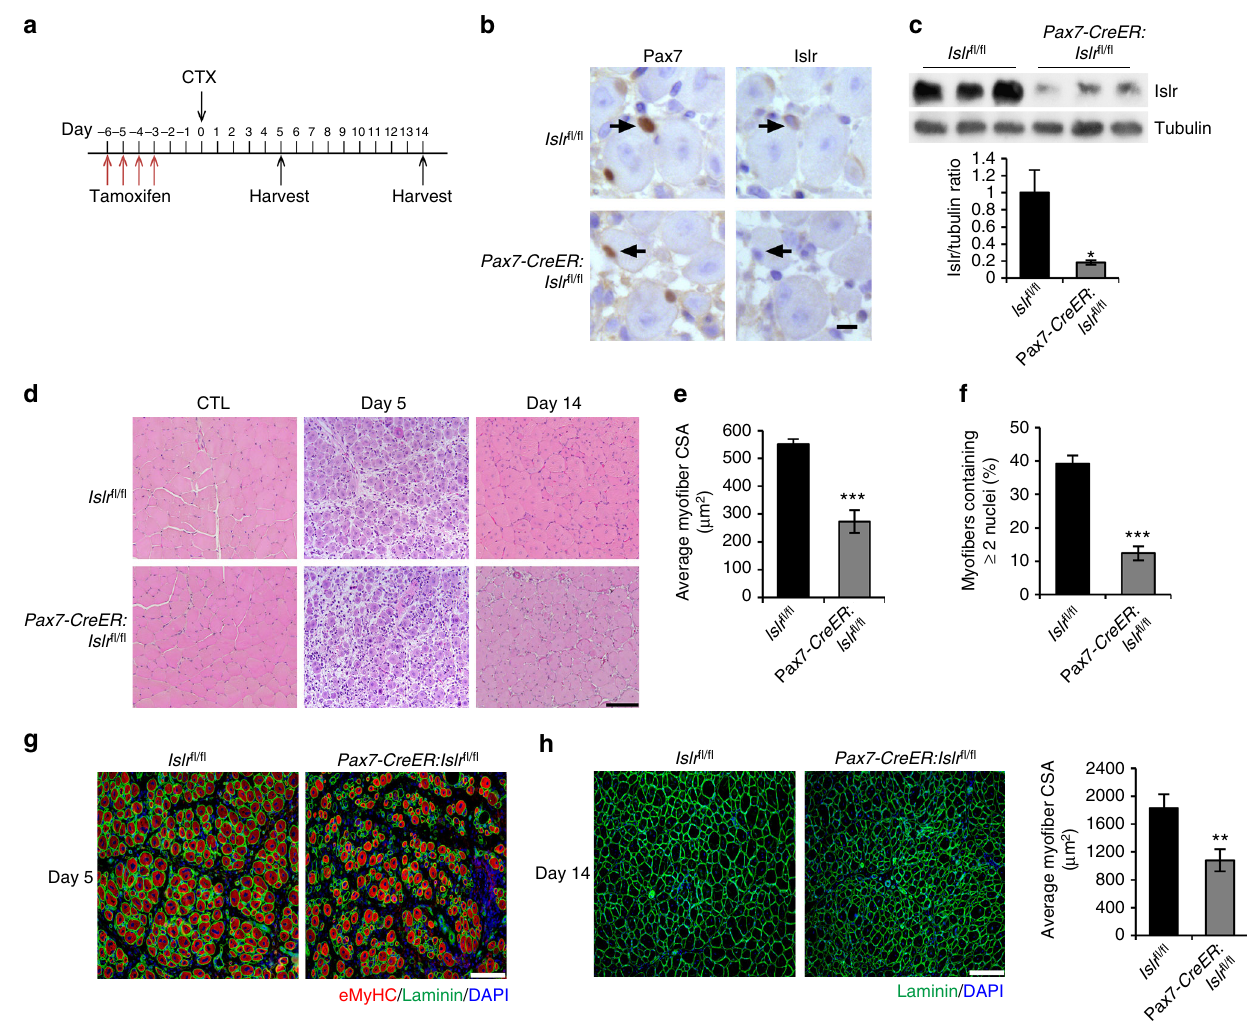
Fig. 5 Inducible deletion of Islr in satellite cells impairs skeletal muscle regeneration. a Schematic outline of CTX injection in tamoxifen-treated Islr fl / fl and Pax7-creER : Islr fl / fl mice at the age of 10 weeks. b Immunohistochemistry analysis of Islr in Pax7 + cells of Islr fl / fl and Pax7-creER : Islr fl / fl mice at 5 d postinjury using serial sections. Scale bar = 10 μ m. c Western blot analysis of Islr protein levels in injured TA muscles of Islr fl / fl and Pax7-CreER : Islr fl / fl mice at 5 d post injury. d H&E staining of injured and CTL in Islr fl / fl and Pax7-CreER : Islr fl / fl mice at 5 and 14 d postinjury. N = 3 in each group. Scale bar = 100 μ m. e CSA of regenerating myo fi bers and f the number of myo fi bers containing two or more centrally located nuclei per fi eld at 5 d postinjury. N = 3 in each group. g Immuno fl uorescence analysis of eMyHC + fi bers in TA muscles of Islr fl / fl and Pax7-CreER : Islr fl / fl mice at 5 d postinjury. N = 3 in each group. Scale bar = 100 μ m. h Immuno fl uorescence analysis of the size of myo fi bers in TA muscles of Islr fl / fl and Pax7-CreER : Islr fl / fl mice at 14 d post injury. N = 3 in each group. Scale bar = 200 μ m. The CSAs are shown on the right. Error bars represent the means ± s.d. * P < 0.05, ** P < 0.01, *** P < 0.001; Student ’ s t